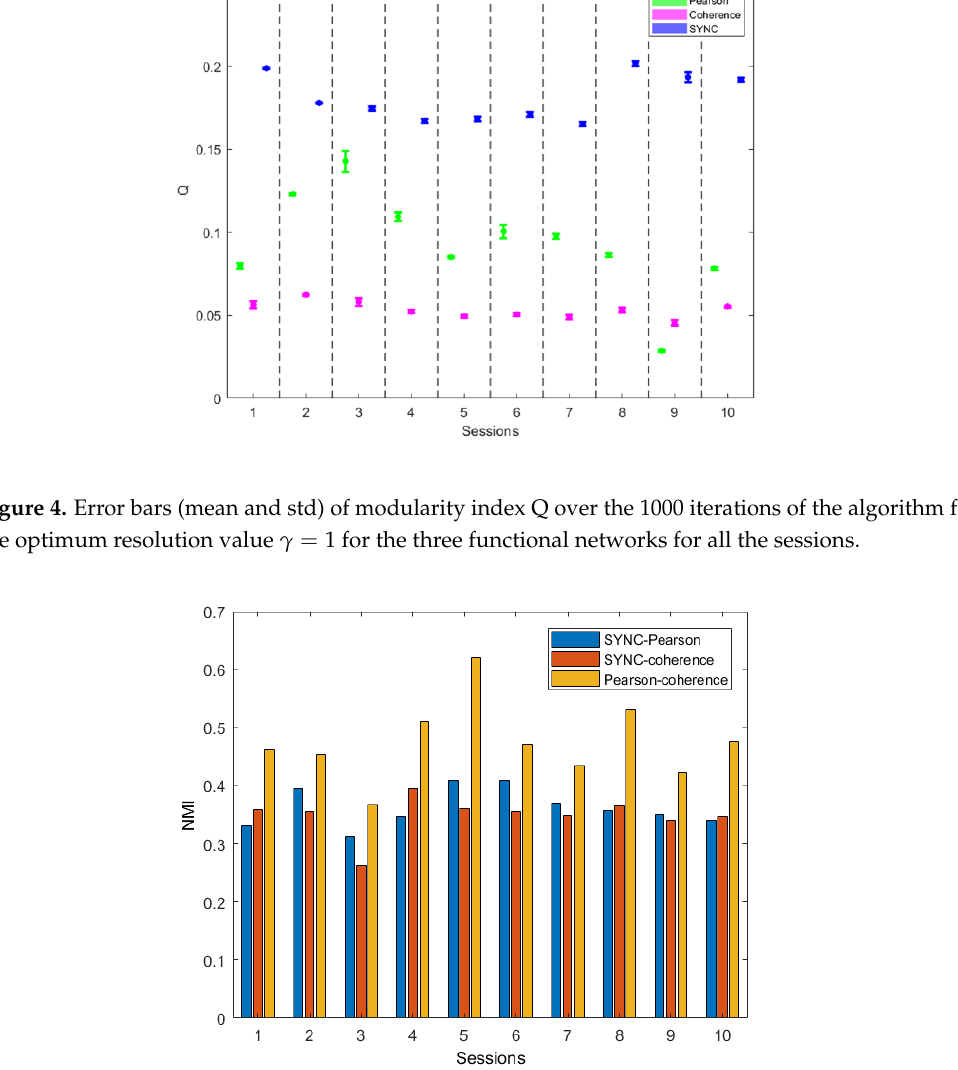
Figure 5. NMI values resulting from the comparisons between each couple of network partitions for all fMRI sessions of the